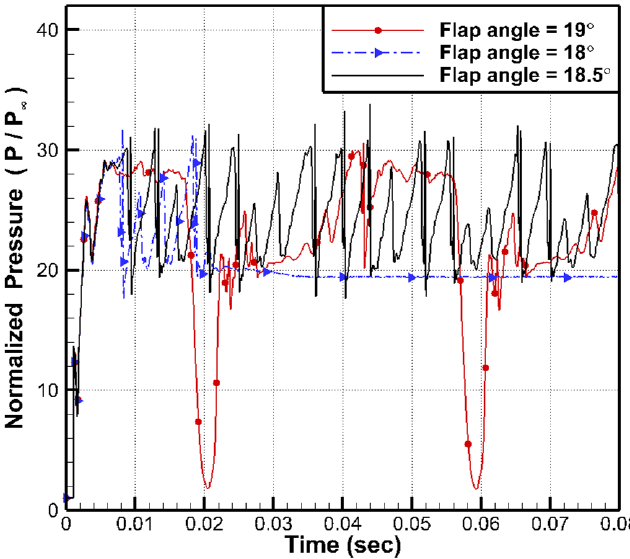
Figure 3. Comparison of the pressure time history at x/h = 12.21 with various flap angles. For a flap angle of 18 ◦ , the normalized pressure (P/P ∞ ) value oscillates between 20 and 30, which is the same pressure oscillation range in NO mode that appeared in the experiment [11]. However, after 0.04 s, the pressure no longer oscillates and represents a constant value. Figure 4 shows the Mach number contour for a flap angle of 18 ◦ at time = 0.05 s. As shown in the figure, supersonic flow exists in the entire flow passage without disconnection, so the inlet is started. Therefore, at a flap angle of 18 ◦ , the inlet state is at the boundary between NO mode and the inlet start state.